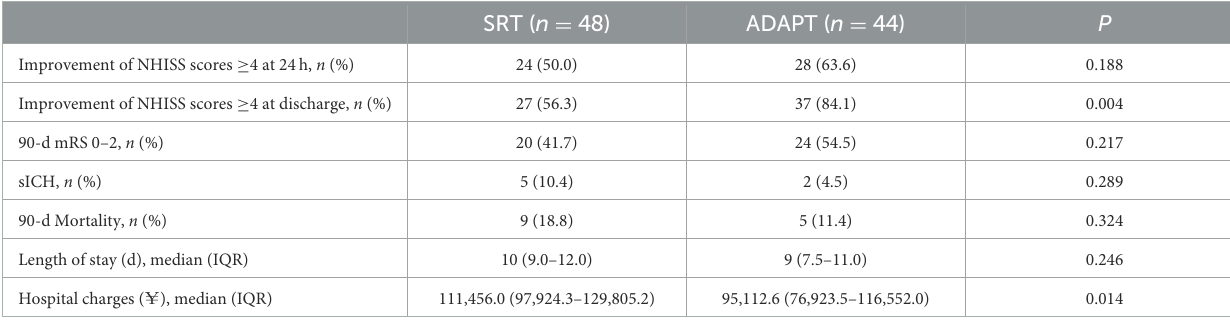
TABLE 2 Clinical outcomes in stroke patients with AF treated by ADAPT or